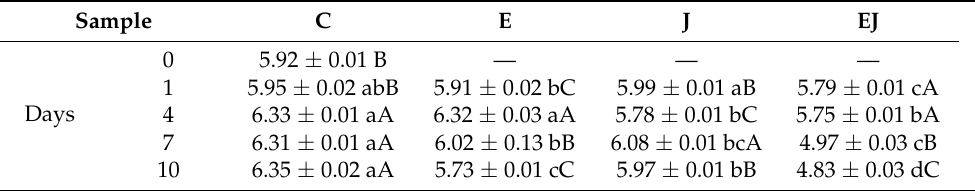
Table 6. pH value of chicken burgers during storage for 10 days: without inoculum (C); with 8% spray-dried extract (E); with inoculum (J); and with 8% of spray-dried extract and inoculum (EJ). Sample C E J